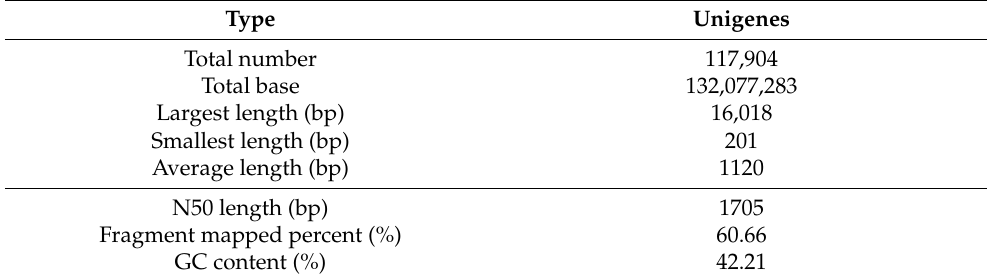
Table 2. Summary of do novo transcriptome assembly for S. tonkinensis